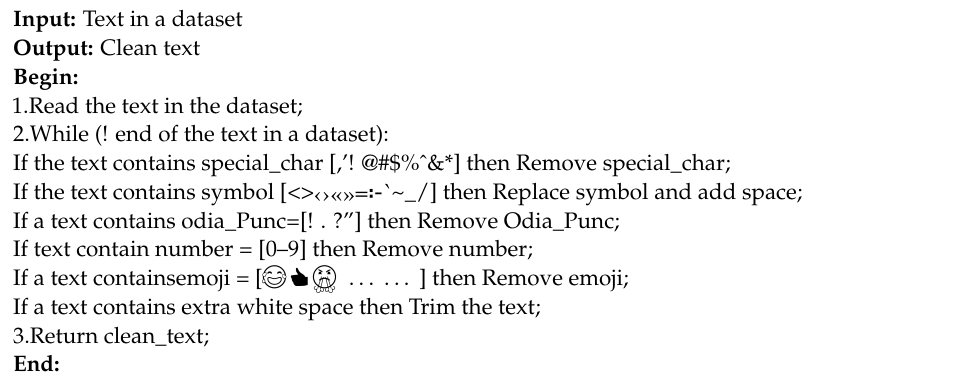
Algorithm 1 Cleanup Odia-English Mixed Text.